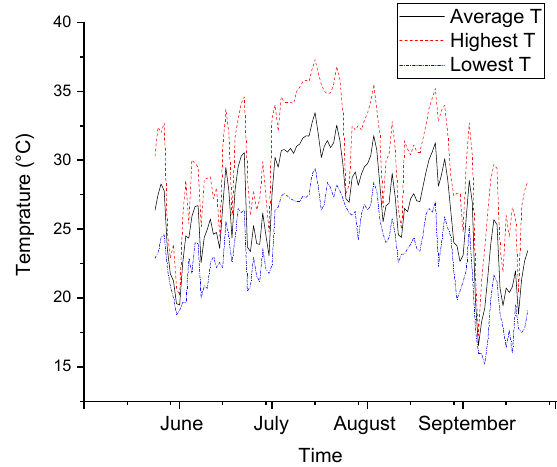
Figure 1. Local typical temperatures from Yiyang meteorological station.